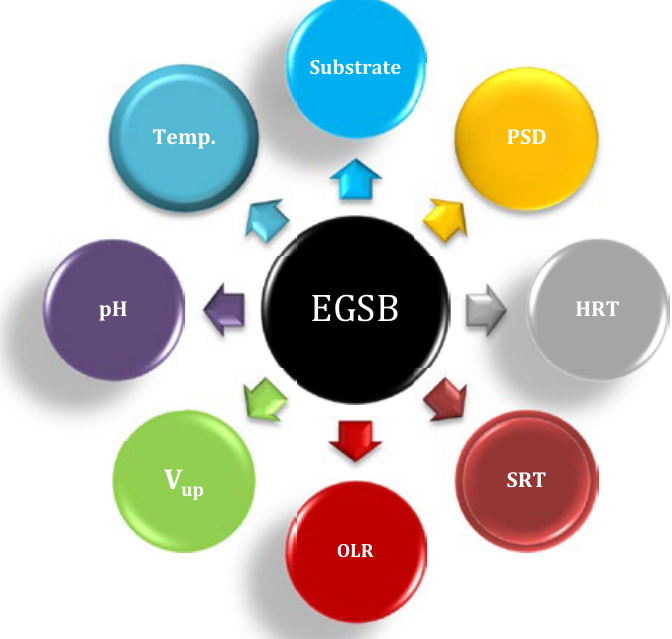
Fig. 3: Factors influencing bioreactor’s performance